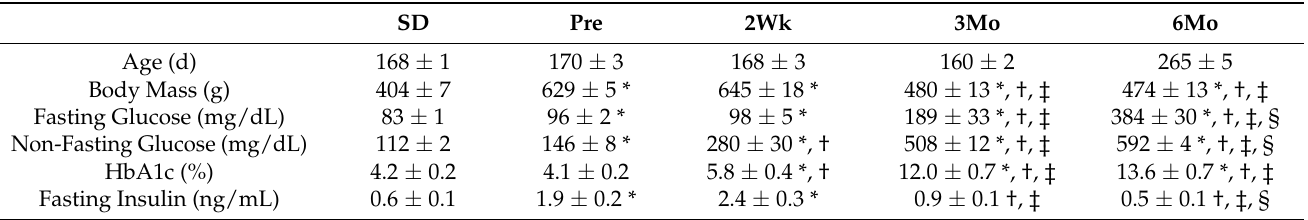
Table 1. Phenotype data for Sprague-Dawley (SD; n = 7), pre-diabetic UCD-T2DM (Pre; n = 9), 2-week diabetic UCD (2Wk; n = 9), 3-month diabetic UCD-T2DM (3Mo; n = 14), and 6-month diabetic UCD- T2DM (6Mo; n = 9) rats. * Significant difference from SD ( p < 0.05). † Significant difference from